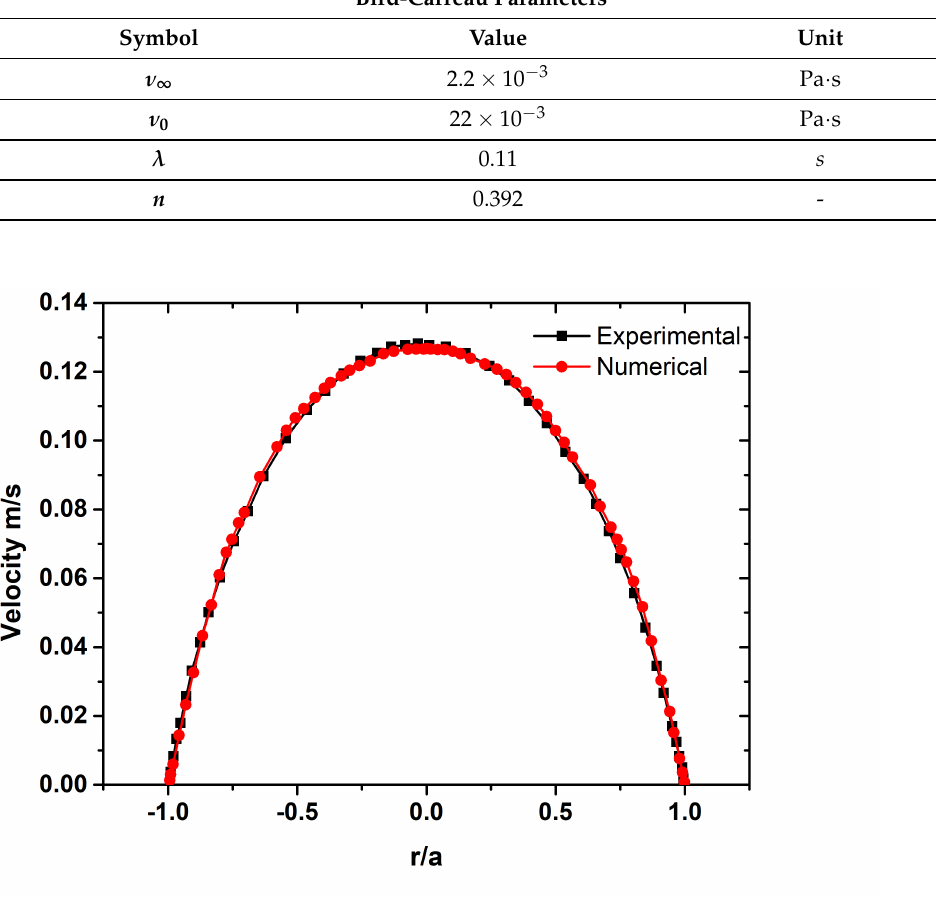
Figure 3. Comparison of axial blood velocity between experimental measurements (black) of Ref [40] and present numerical simulation